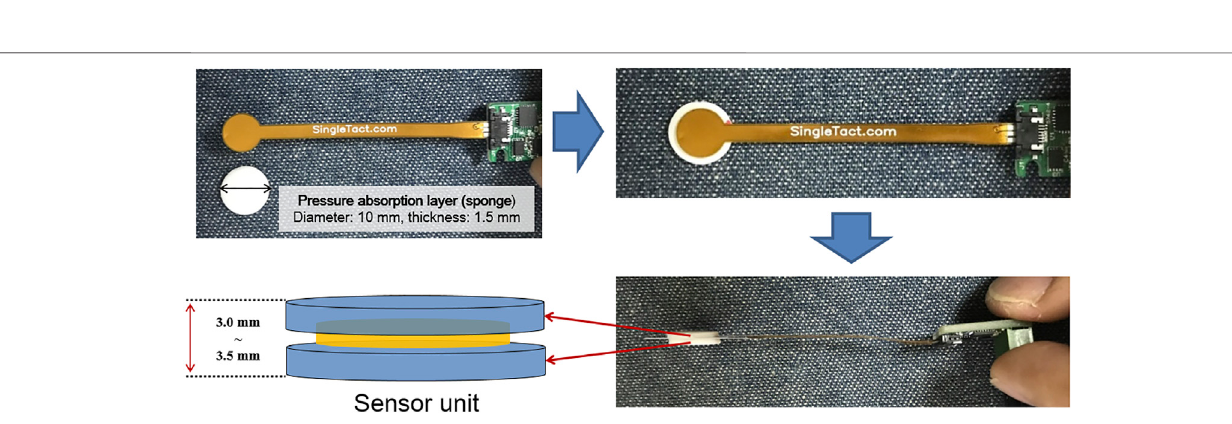
Frontiers in Robotics and AI |